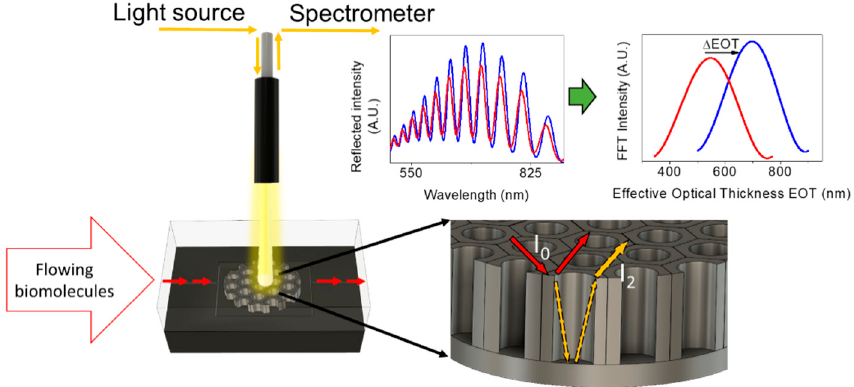
Figure 2. Explicative scheme of the Reflectometric Interference Spectroscopy system (RIfS).